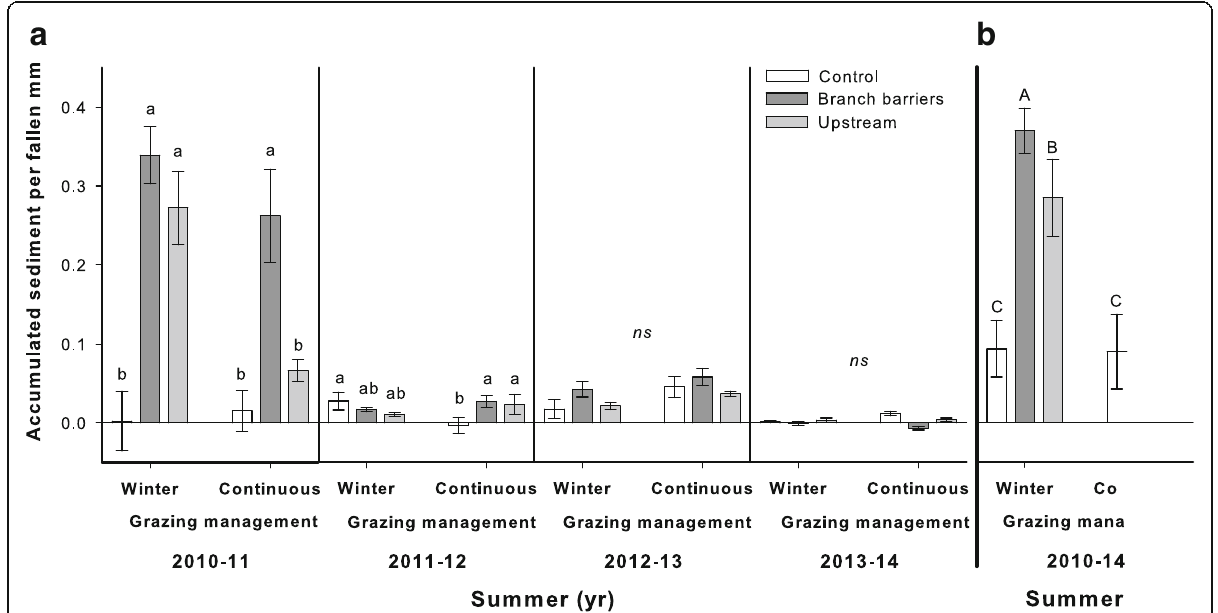
Fig. 2 Mean (± standard deviation, SE) of accumulated sediment per millimetre of rain fallen during the summer season ( a ), and mean (±SE) net summer sediment accumulation during the study period (2010 – 2014) ( b ) in water run-off paths with branch barriers (branch barriers), 3 m upstream of branch barriers (upstream) and in run-off paths without branch barriers (control); under different grazing managements: winter (a 1- ha temporary enclosure in which grazing was excluded until winter season, when it was grazed with a stocking rate adjusted to annual forage availability), and continuous (a 1-ha paddock that remained open to grazing throughout the year with a stocking rate of 0.16 AU ha − 1 ). Different lowercase letters showed significant differences for grazing management × branch barriers interaction ( ɒ = 0.05). Different uppercase letters indicated significant differences between levels of one factor ( ɒ =